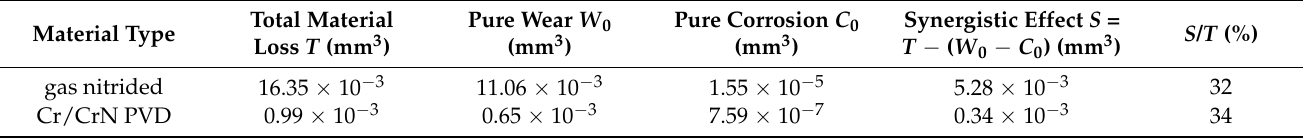
Table 6. An analysis of tribocorrosion wear components under the load of 13